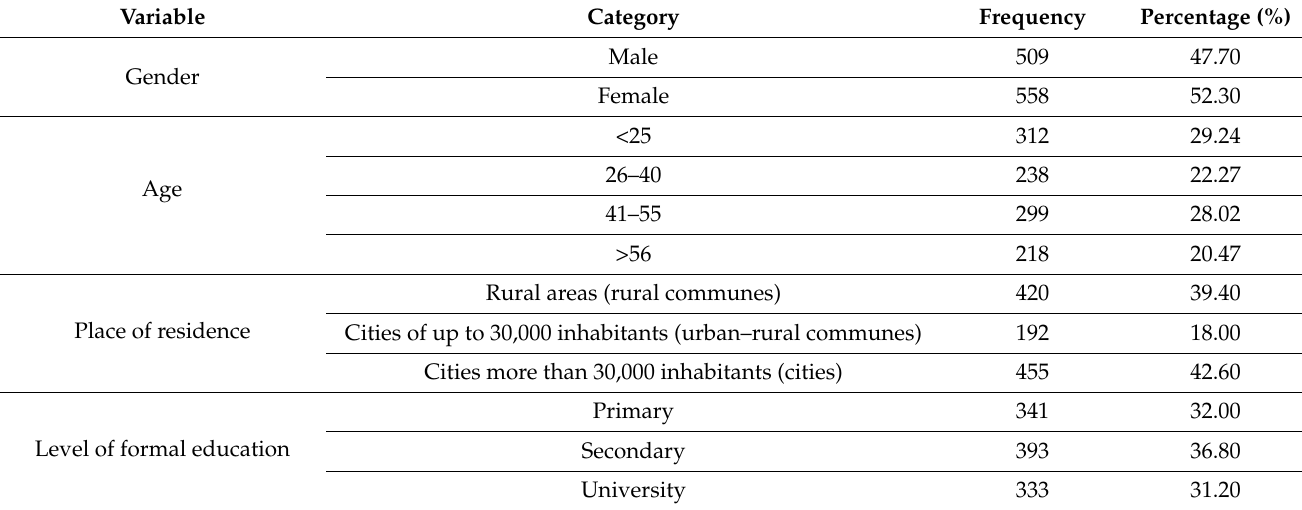
Table 1. Demographic descriptions of the sample ( n = 1067).